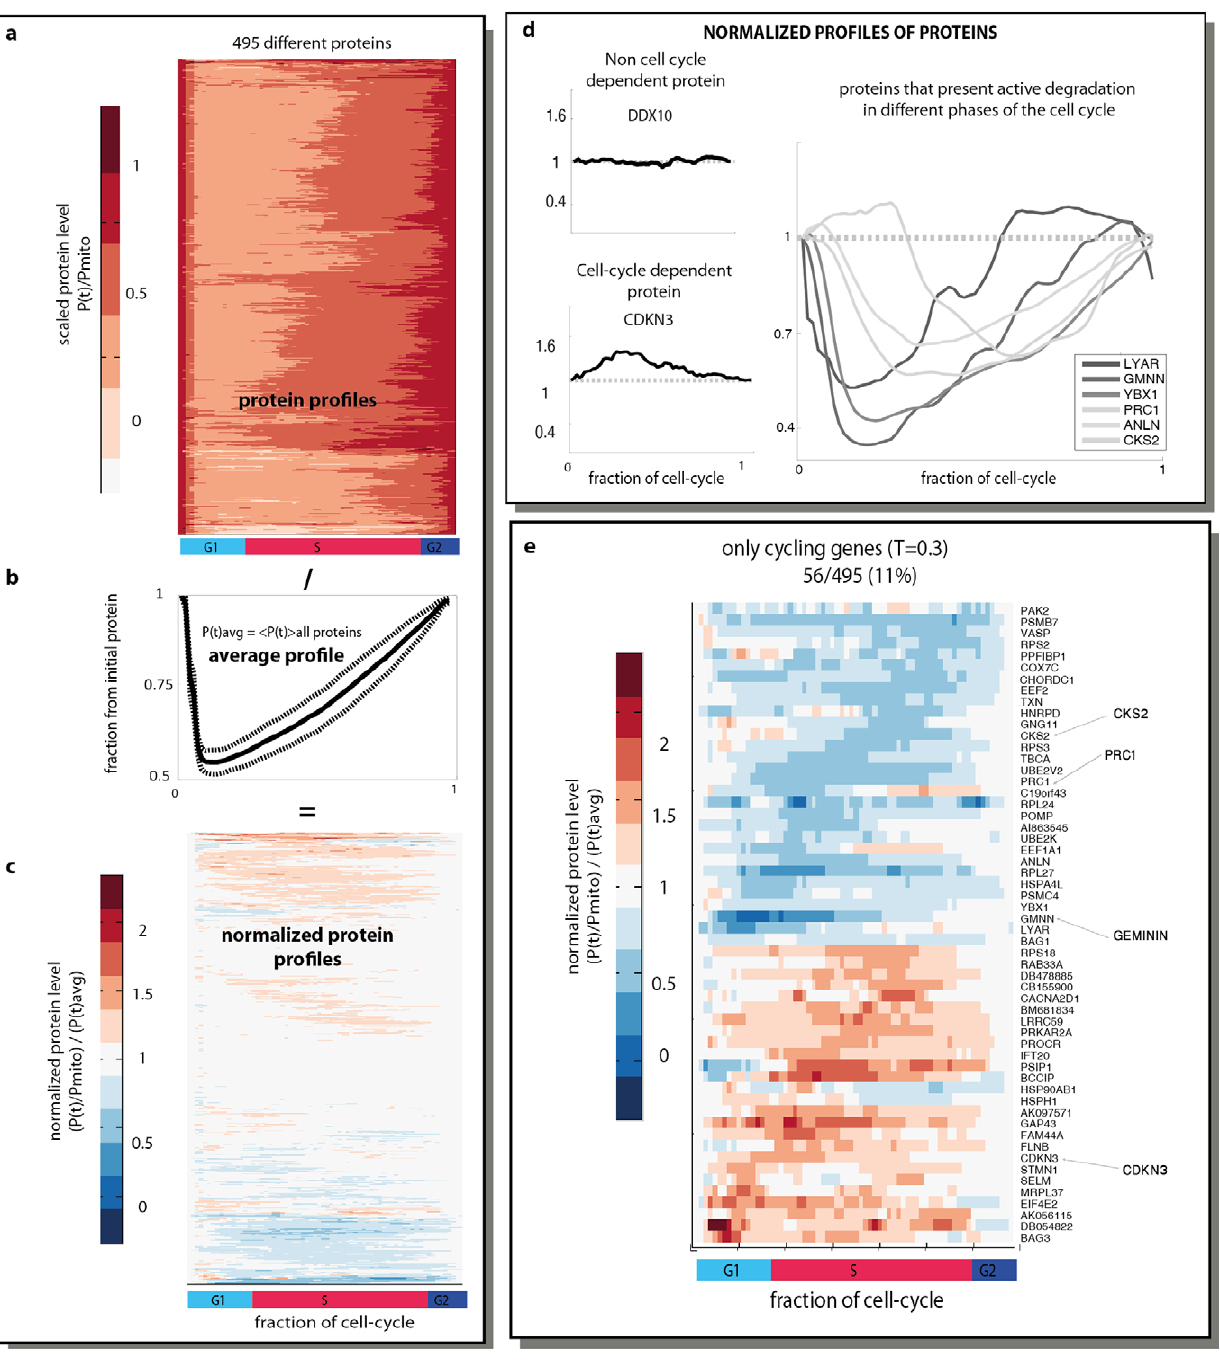
Figure 2. Cell cycle dependence of protein levels. (A) Fluorescence averaged over all cells for 495 proteins, as a function of fraction of cell cycle. Each profile was normalized by the initial level of protein before mitosis to factor out different absolute expression levels. (B) Average profile of over all proteins. Dashed lines represent the standard deviation. (C) Fluorescence profiles normalized by the average profile were clustered using hierarchical clustering. (D) Examples for different clusters of proteins are shown. (E) Normalized profiles of the 56 cycling proteins are presented. small but significant overlap (7 of the 29 cycling proteins that were measured here and were also investigated in Whitfield et al were evaluated as cycling on the mRNA level (hypergeometric p-value = 0.02).